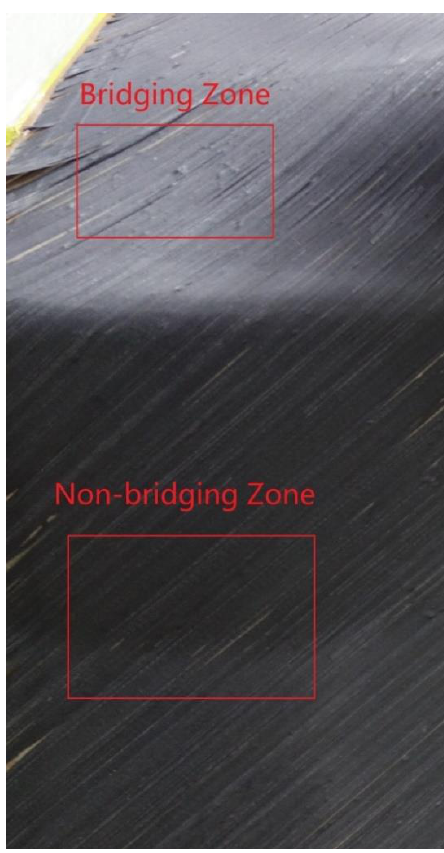
Figure 22. The surface state of the first layer is made by AFP: with and without tension adjustment.